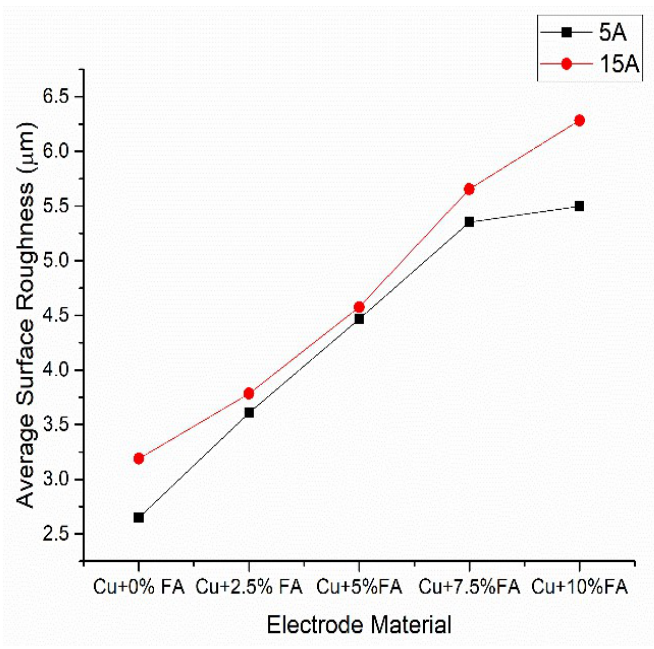
Figure 7. Effect of the electrode material and the average roughness of the surface.